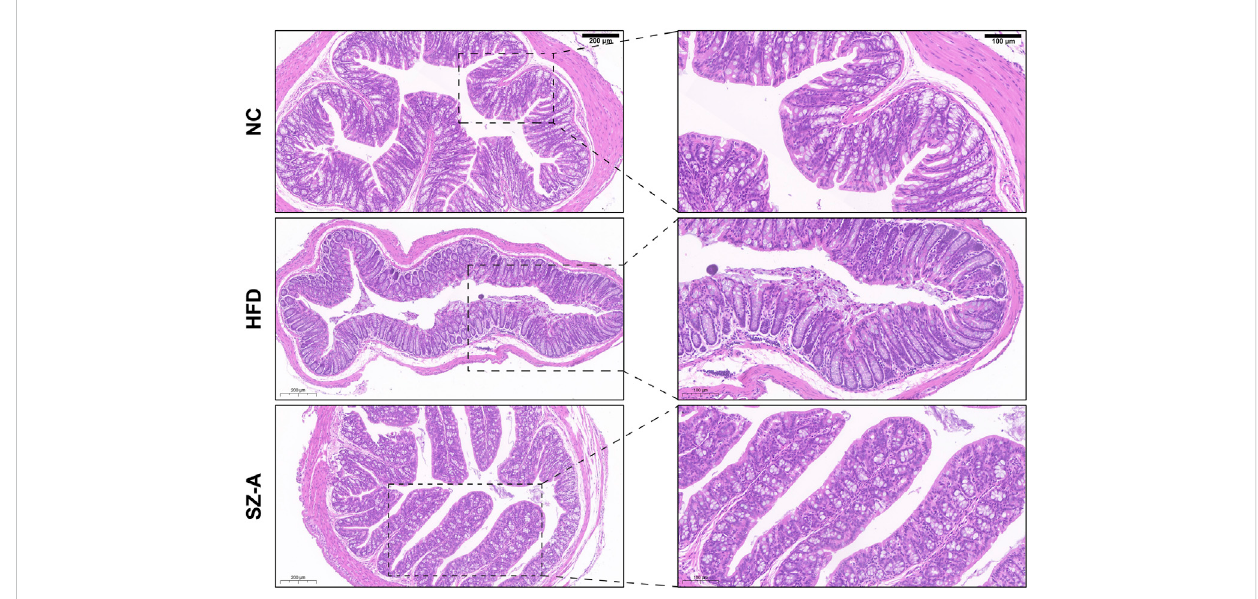
FIGURE 5 SZ-A alleviated colon in fl ammatory injury and pro-in fl ammatory macrophage in fi ltration in mice. Representative H&E staining images of the colon